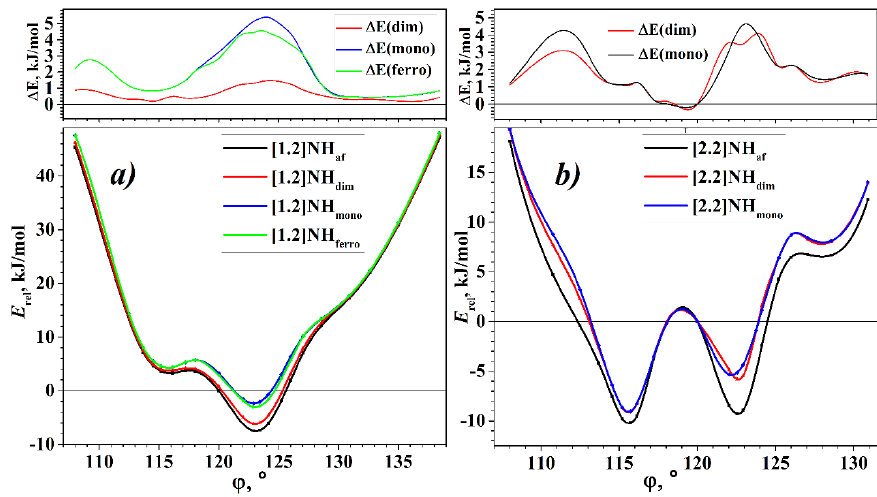
Figure 2. Torsion energy curves of NHs, E rel (state, 𝜑 ), and torsion curves of energy differences be- tween states, Δ E (state, 𝜑 ) = E rel (state, 𝜑 ) – E rel (af, 𝜑 ). ( a ) [1.2] helicene; ( b ) [2.2] helicene.